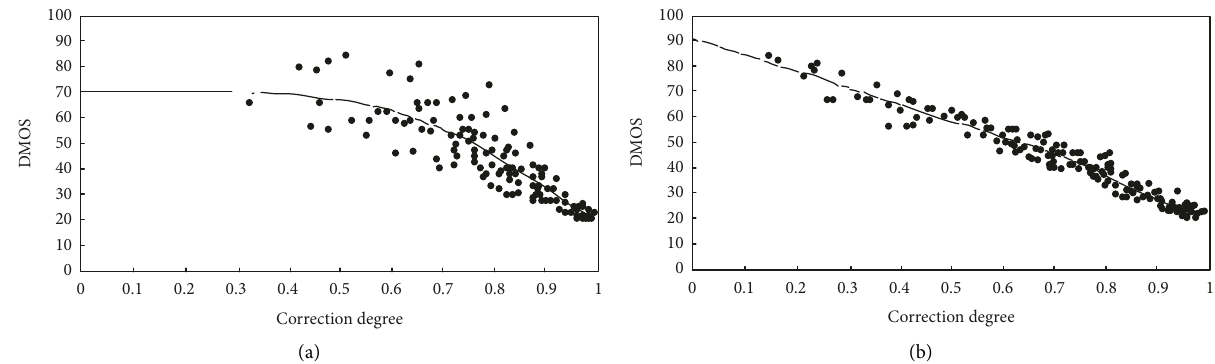
Figure 2: Edge correction scatter of Gauss blur distortion image. (a) Control group. (b) Experience group.